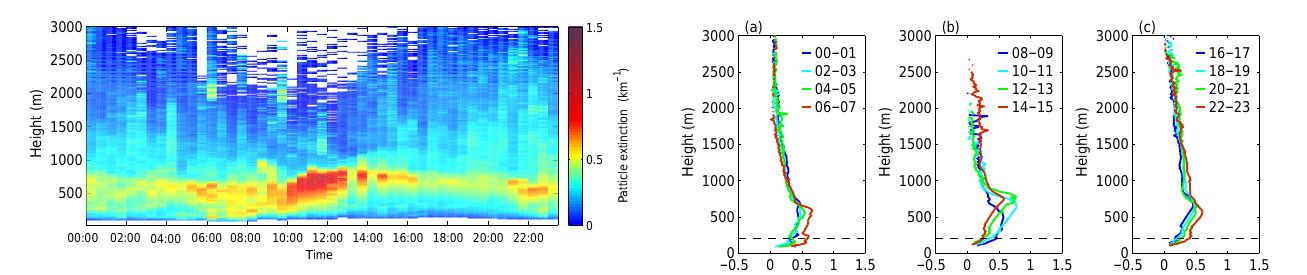
Figure 2. Average diurnal patterns of vertical distribution of particle extinction. Figure 3. Vertical profiles of particle extinction averaged every